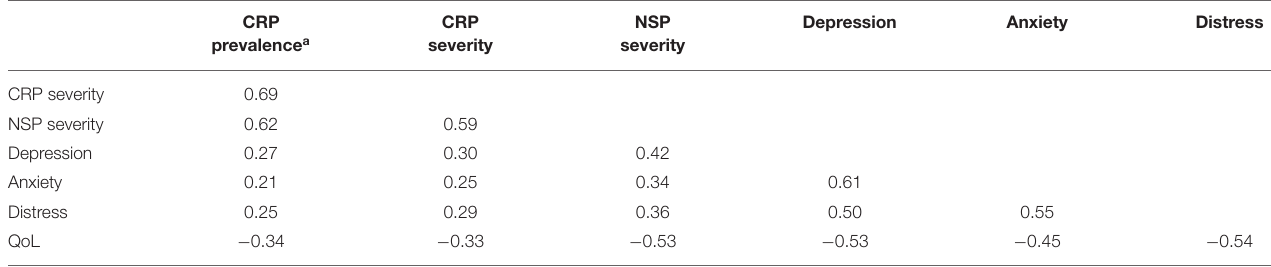
TABLE 3 | Correlations between pain and psychological